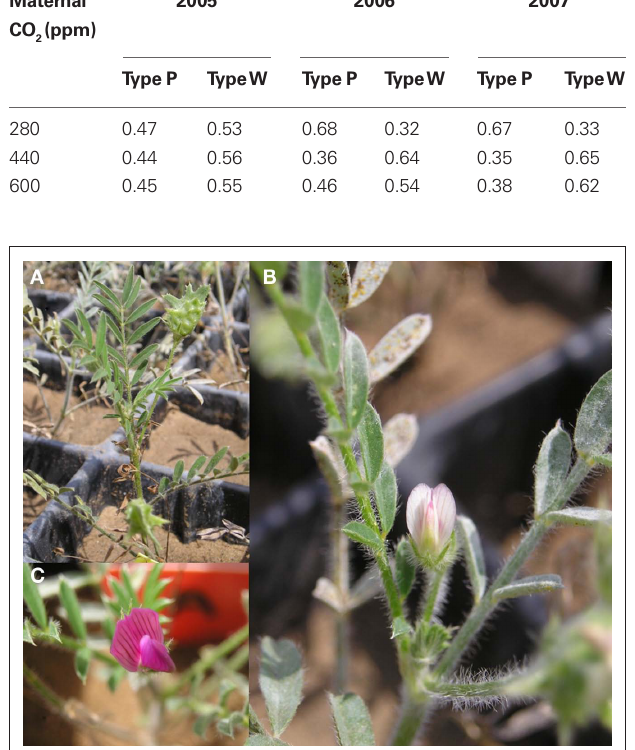
Figure 1 | Onobrychis crista-galli (cock’s comb sainfoin) plant with developing fruits (A), white-flowering plant type showing symptoms of powdery mildew (B), pink-flowering plant type (C).